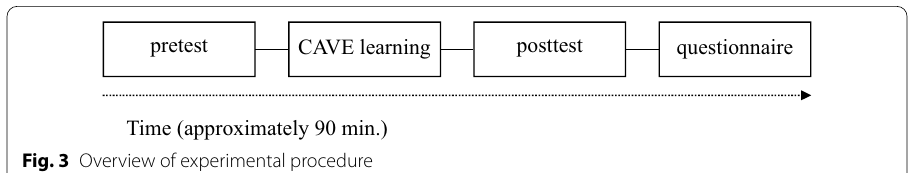
Fig. 3 Overview of experimental